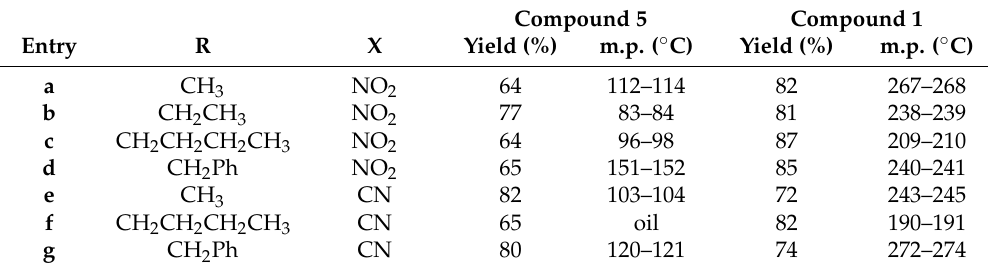
Table 1. Compounds prepared by double alkylation followed by double S N Ar. (Note: Spectral data for compounds 5a – g and 1a – g are in the Supplementary Materials).